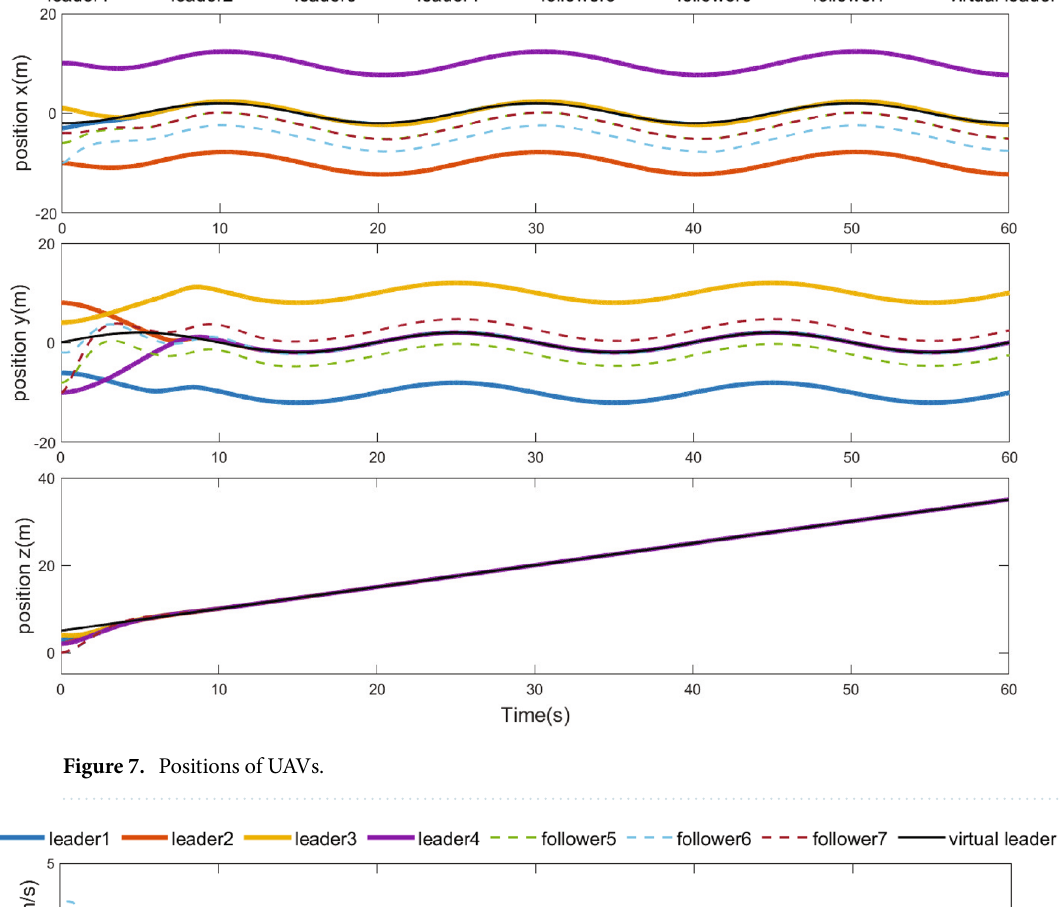
Figure 7. Positions of UAVs.